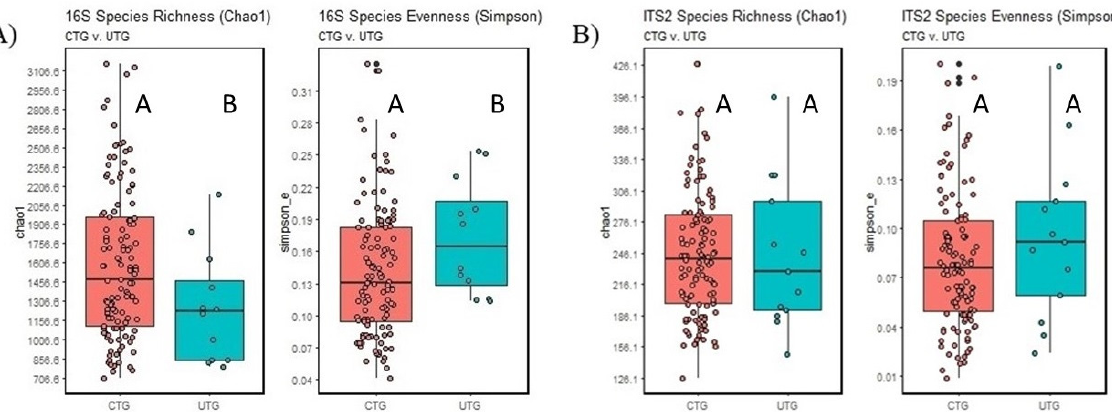
Figure 1. Alpha diversity metrics for CTG and UTG. ( A ): Bacterial community. ( B ): Fungal community. For each metric, columns marked by differing letters are significantly different (Wilcoxon test, BH-adjusted p < 0.05).